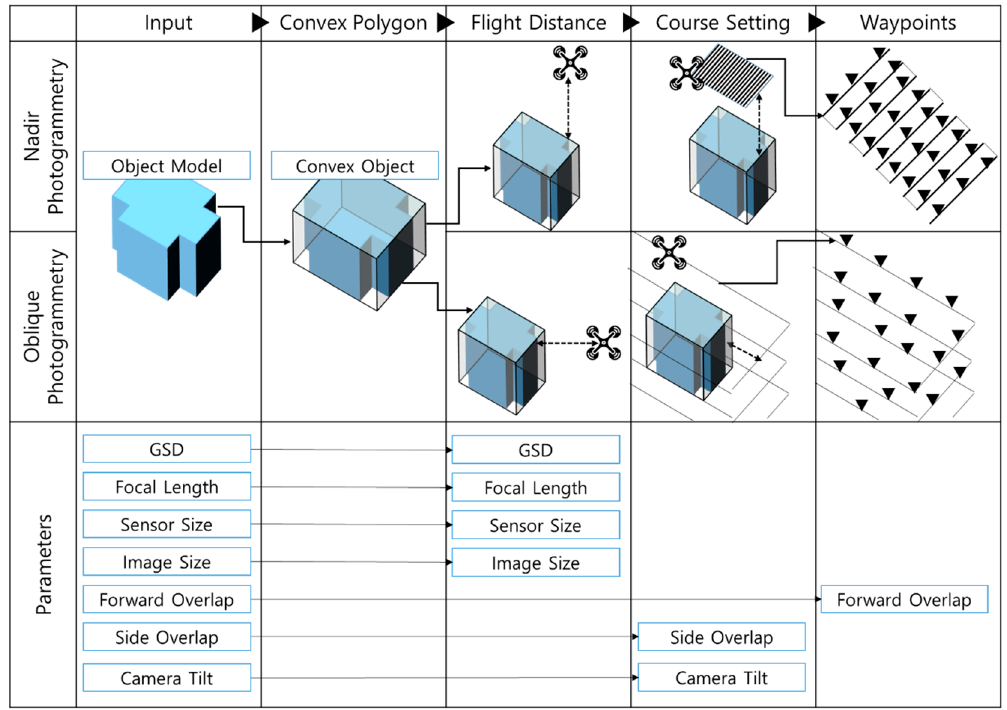
Figure 3. Overall process of automatic path planning in the simulator.